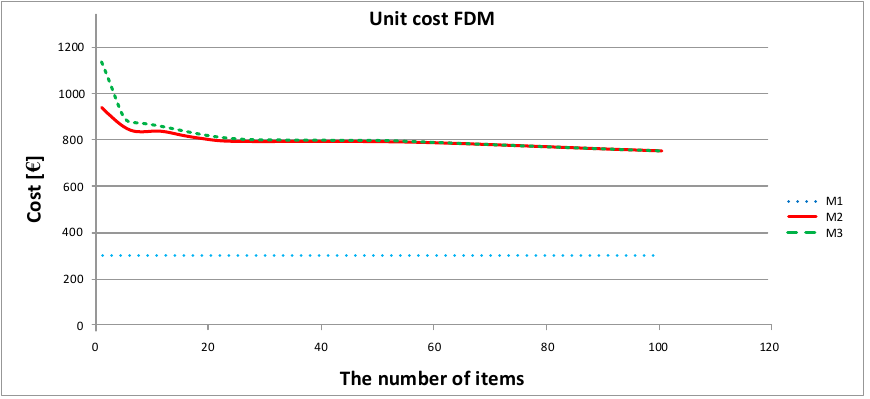
Figure 9. Dependence of the rotor production costs on the number of prototypes for PJM technology.